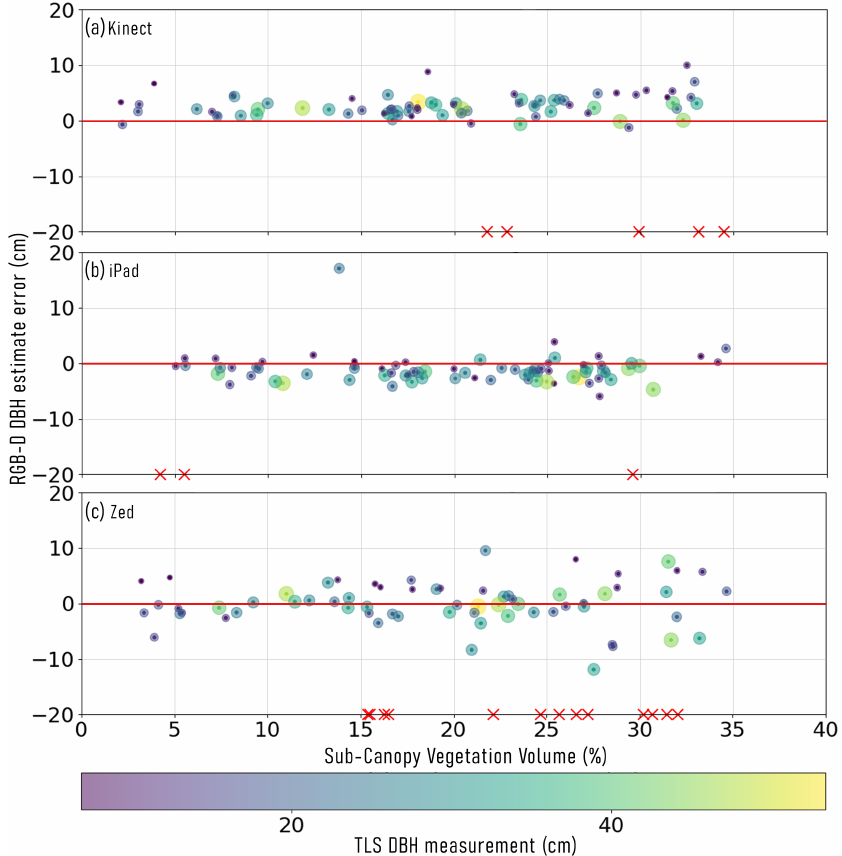
Figure 6. Stem diameter at breast height (DBH) measurement error (cm) derived from colour and depth (RGB-D) sensors, and the volume of understory vegetation surrounding each stem within RGB-D device range and below device height (1.3m). ( a ) Microsoft Azure Kinect, ( b ) Apple iPad Pro 2020, and ( c ) Stereolabs Zed 2. The symbol size and colour around points represents the DBH of each stem measured with terrestrial laser scanning (TLS). The red × symbols on the x-axis represent trees that were unable to be captured using the respective RGB-D sensor and the volume of understory vegetation within the capture range of that